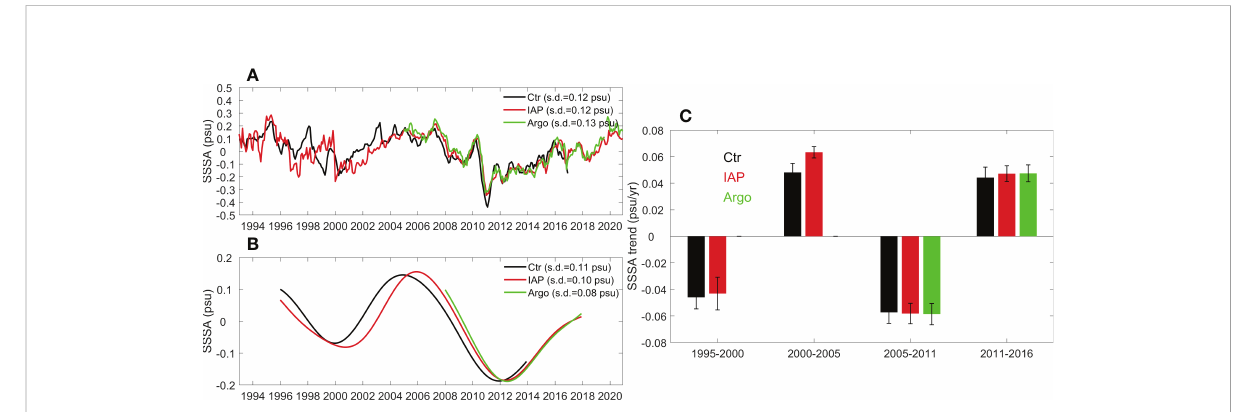
FIGURE 1 (A) Time series of monthly sea surface salinity anomaly (SSSA; in psu) averaged over the SEIO region (14 o -28 o S, 95 o -115 o E) from ROMS Ctr (black), IAP (red), and gridded Argo data (green). The standard deviation is also shown in the legend box. (B) As in (A) , but for 6-yr low-pass- fi ltered SSSA. (C) Linear trends of SSS in the SEIO for the periods of 1995-2000, 2000-2005, 2005-2011, and 2011-2016 derived from Ctr (black), IAP (red) and Argo (green). Error-bars denote the 90% con fi dence interval based on an F